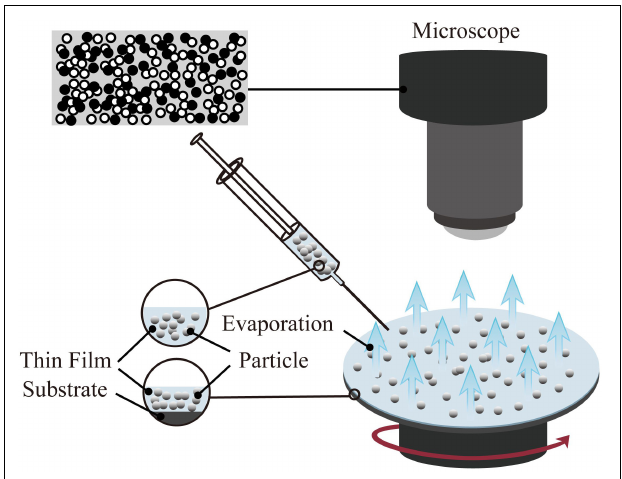
FIGURE 3 | Schematic diagram of spin coating method(the target particles are applied onto the substrate, and then it accelerated to a high angular velocity to simultaneously spread the liquid over the entire surface and evaporate the solvent to achieve the target